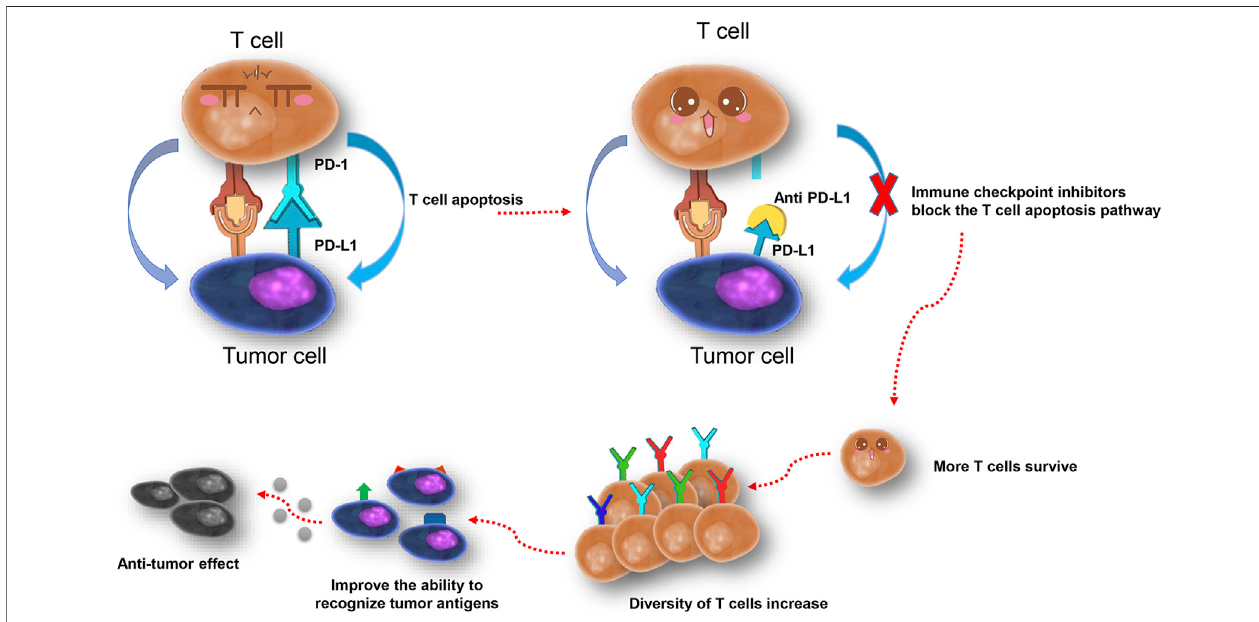
FIGURE 5 | One possible explanation of the increase of T cells and TCR repertoire diversity after PD-L1